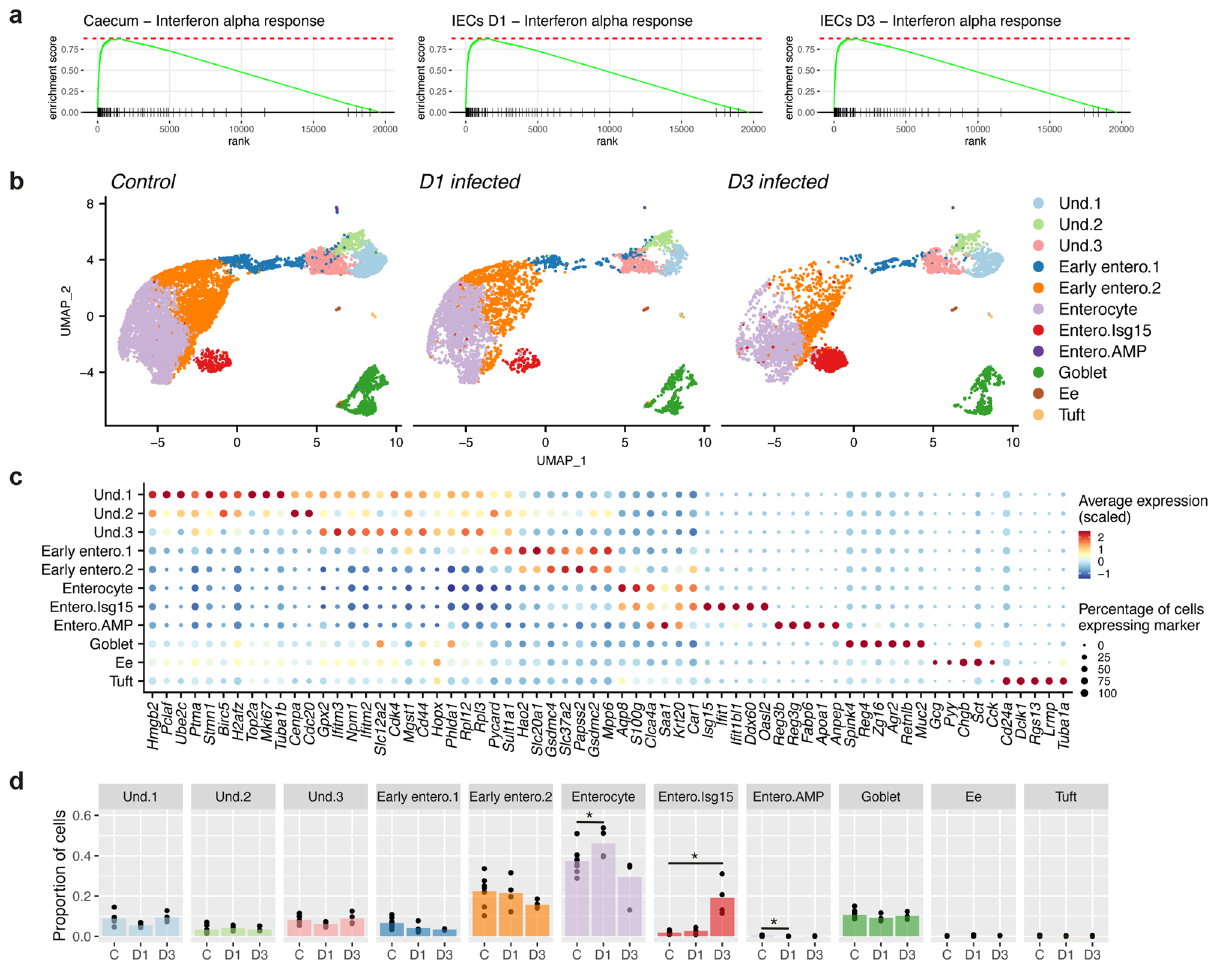
Fig. 8 Host IECs responses to early infection with whipworms are dominated by a type-I IFN signature. a Bulk RNA-seq data from complete caecum and caecal IECs of T. muris -infected and uninfected mice at days 7, and 1 and 3 p.i., respectively, were analysed by gene set enrichment analysis (GSEA) for cell signature genes in the IFN alpha pathway. All analyses have false discovery rate (FDR) adjusted p-values: Caecum, 0.013; day 1 (D1) IEC, 0.025; day 3 (D3) IEC, 0.026. b Uniform manifold approximation and projection (UMAP) plots from single-cell RNA-seq analysis of 22,422 EpCAM + CD45 − cells. IEC populations (colour coded) in the caecum of control ( n = 8, 4 mice for each timepoint) and T. muris -infected mice after 1 and 3 days p.i. ( n = 4 mice for each timepoint). UMAP representations with separate day-1 and day-3 controls are shown in Supplementary Fig. 10e. c Dot plot of the top marker genes for each cell type. The relative size of each dot represents the fraction of cells per cluster that expresses each marker; the colour represents the average (scaled) gene expression. d Increased relative abundance of the Enterocyte Isg15 cluster upon 72 h of T. muris infection. The size of the clusters, expressed as a proportion of the total number of cells per individual, was compared across four biological replicates at each timepoint for uninfected and T. muris- infected mice. Mean + / − standard deviation is shown (* p = 0.036 for Enterocyte, * p = 0.031 for Entero.Isg15 and * p = 0.030 for Entero.AMP, two-tailed t test). Source data are provided as a Source data fi